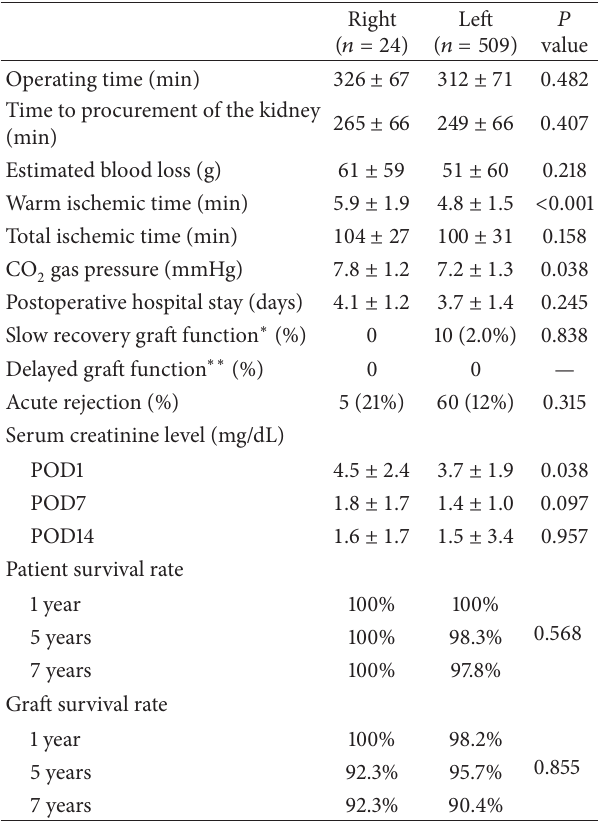
Figure 1: Port placement and pfannenstiel incision in right and left RPLDN. Table 2: Characteristic demographics for donors and recipients in Table 3: Postoperative outcomes of right and left right and left RPLDN.